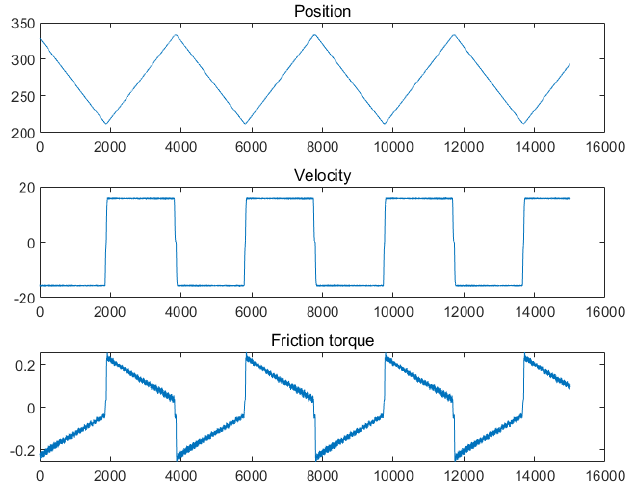
Figure 2. Robot joint torque signal.